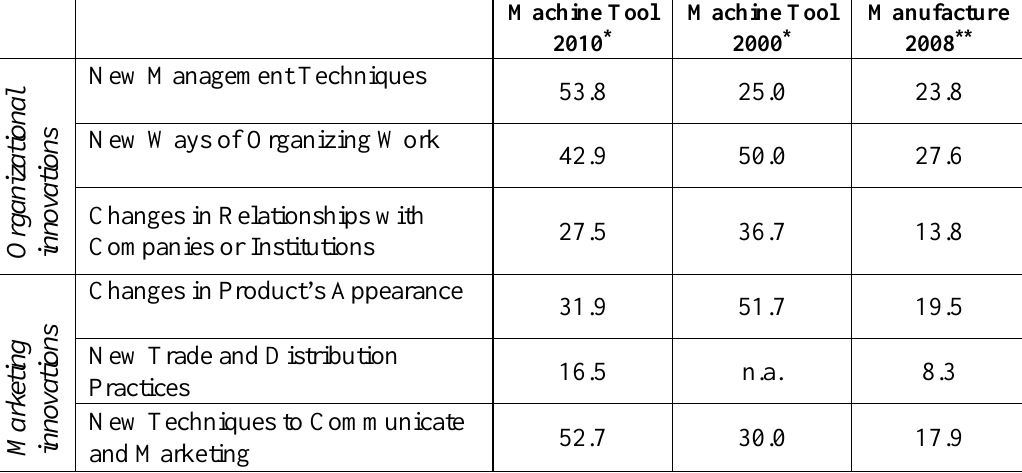
Table 4: The Introduction of Organizational and Marketing Innovations in the Last Three Years (% of Total Enterprises)